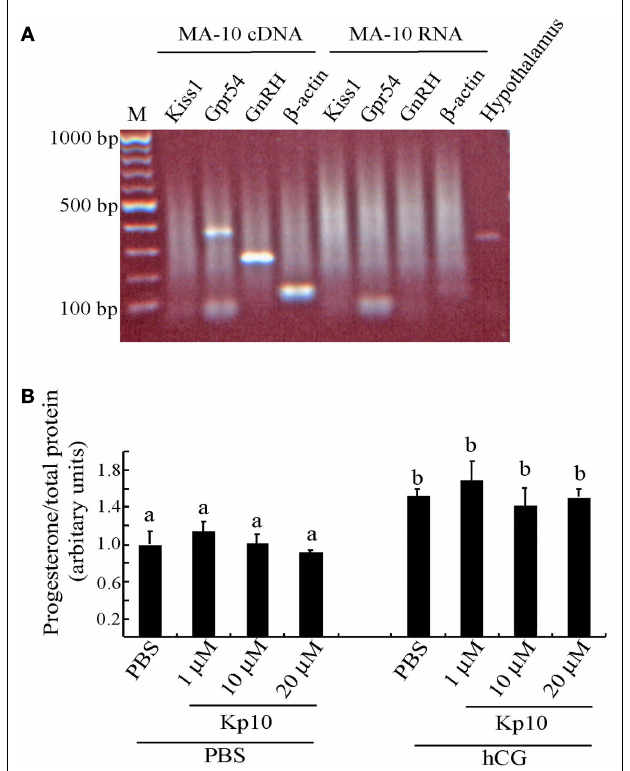
FIGURE 3 |The MA-10 Leydig cell line expresses Gpr54 but do not respond to Kp10 treatment . (A) RT-PCR gene expression analysis in the MA-10 Leydig cell line. Expression of Gpr54 , GnRH , and β -actin was detected in cDNA from the MA-10 cells but Kiss1 expression was not detected. Hypothalamic cDNA was included as a positive control for Kiss1 expression. (B) Effect of Kp10 on stimulating progesterone release from the MA-10 cell line.The MA-10 cells were stimulated with the hormones indicated and media collected after 4h and tested for progesterone. Different letters (a and b) indicate statistically significant differences between groups ( P < 0.05, one way ANOVA with aTukey comparison